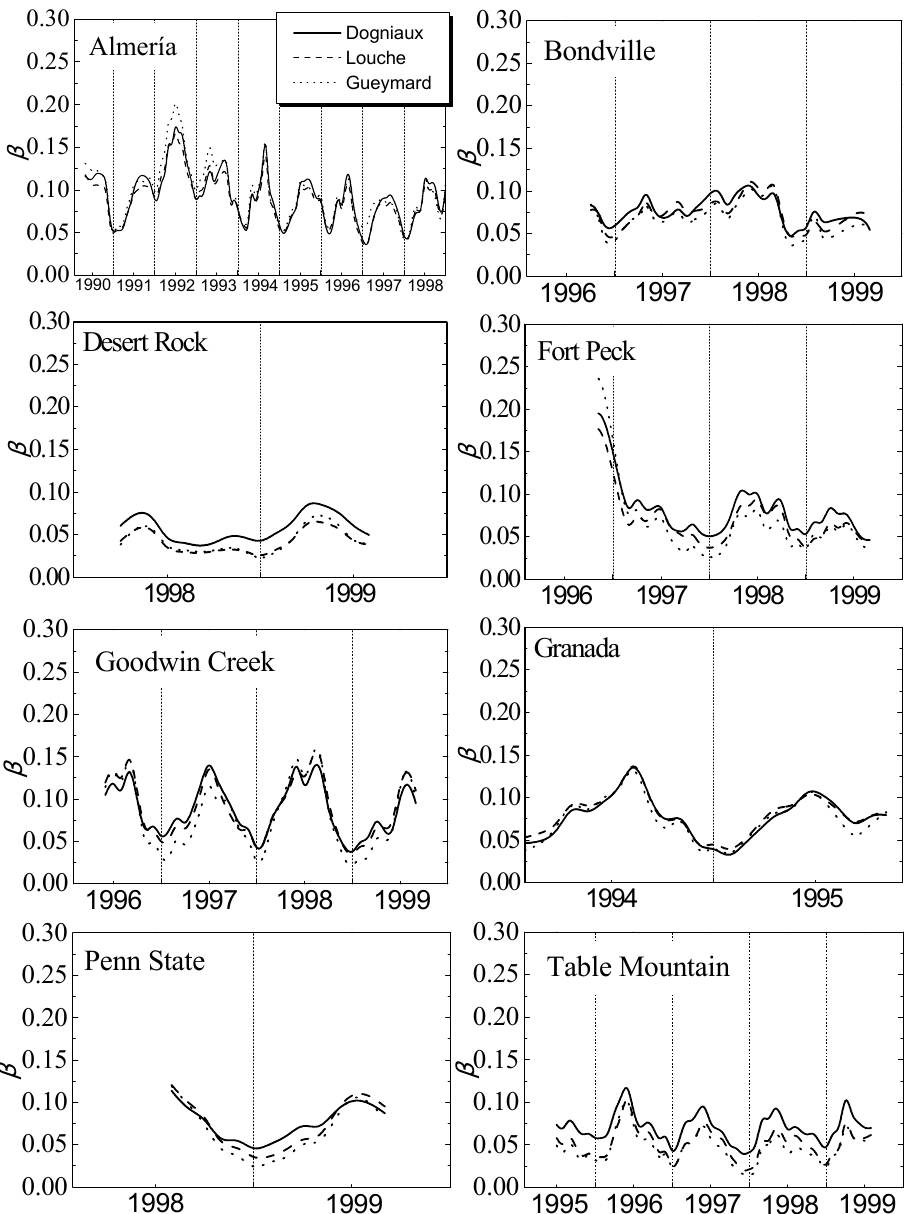
Figure 9 Fig. 9. Annual evolution of monthly mean values of turbidity coefficient β calculated by each turbidity algorithm at each